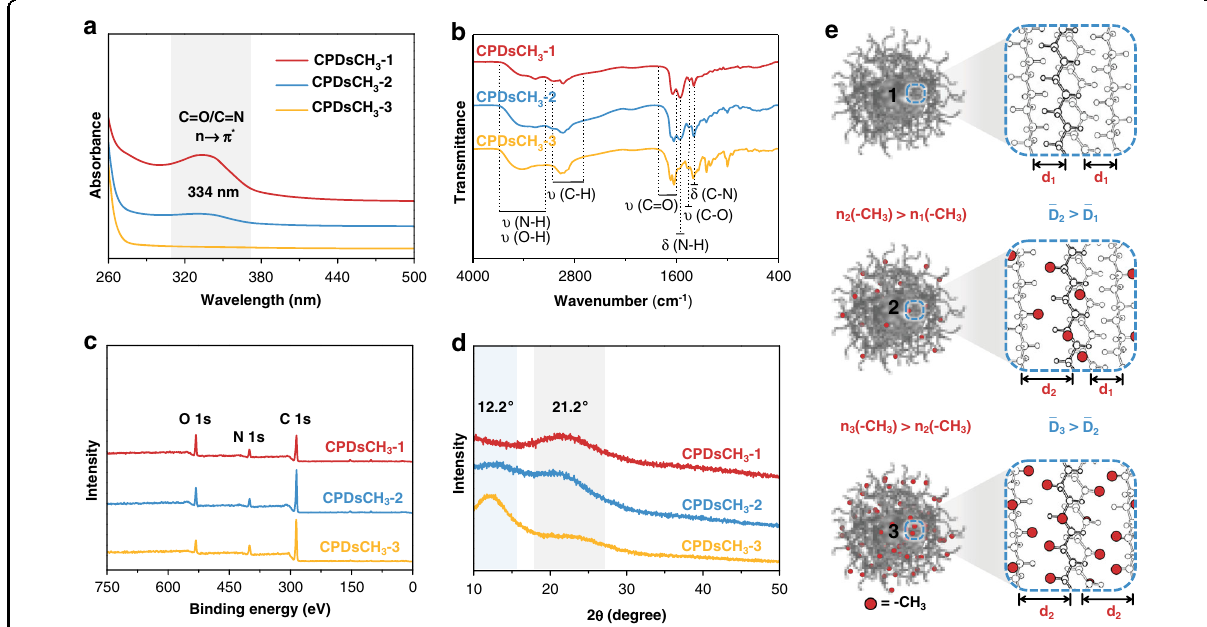
Fig. 3 Effect of the methyl groups on the structures of CPDs. a UV – vis absorption spectral pro fi les. b FTIR spectral pro fi les. c XPS spectral pro fi les. d XRD patterns. e Schematic of the relationship between the methyl groups and the internal structure of CPDs (d 1 : the spacing of the original skeleton inside CPDs without methyl groups. d 2 : the spacing of the stretched skeleton inside CPDs by methyl groups. D 1 : average skeleton spacing of CPDsCH 3 -1. D 2 : average skeleton spacing of CPDsCH 3 -2. D 3 : average skeleton spacing of CPDsCH 3